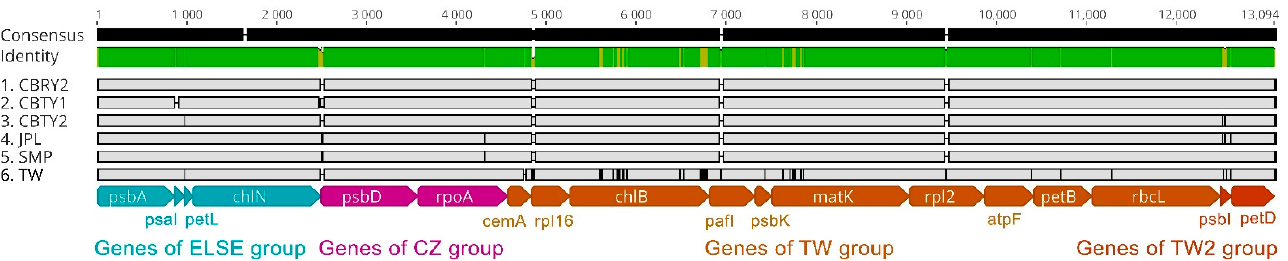
Figure 5. The alignment of polymorphic chloroplast genes between Cathaya argyrophylla populations located at different locations in China. Each gene is marked by different colored bars below the alignment. Each color represents a specific group classification for one unique polymorphic type. CBTY1, CBTY2 and CBRY2 were collected from Chengbu County of the Hunan Province. JPL and SMP were collected from Chengzhou City of the Hunan Province. TW was obtained from a previ- ously published study, in which the samples were collected from Taipei City of the Taiwan Prov- ince. Table 2. Information regarding the polymorphic chloroplast genes between Cathaya argyrophylla populations located at six different locations in China.